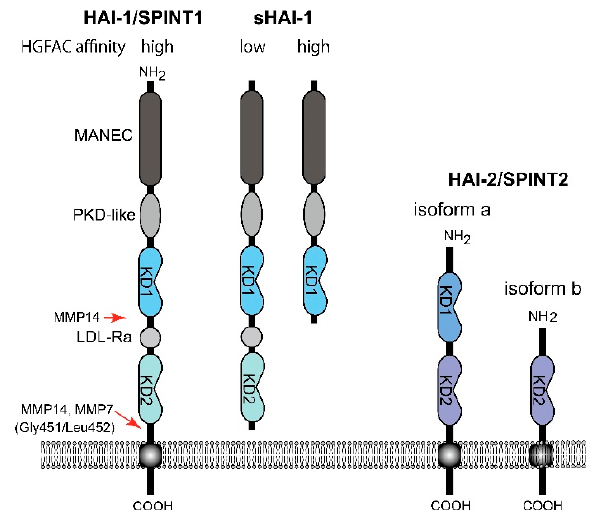
Figure 3. Molecular structure of HAI-1/SPINT1 and HAI-2/SPINT2. Whereas the membrane-form HAI-1/SPINT1 and sHAI-1 only with KD1 show high affinity to HGFAC, sHAI-1 having both KD1 and KD2, shows decreased affinity to HGFAC. MANEC, N-terminus with eight-cysteines domain; PKD-like, polycystic kidney disease domain-like domain; LDL-Ra, low density lipoprotein receptor class A domain; KD, Kunitz domain; MMP, matrix metalloprotease.